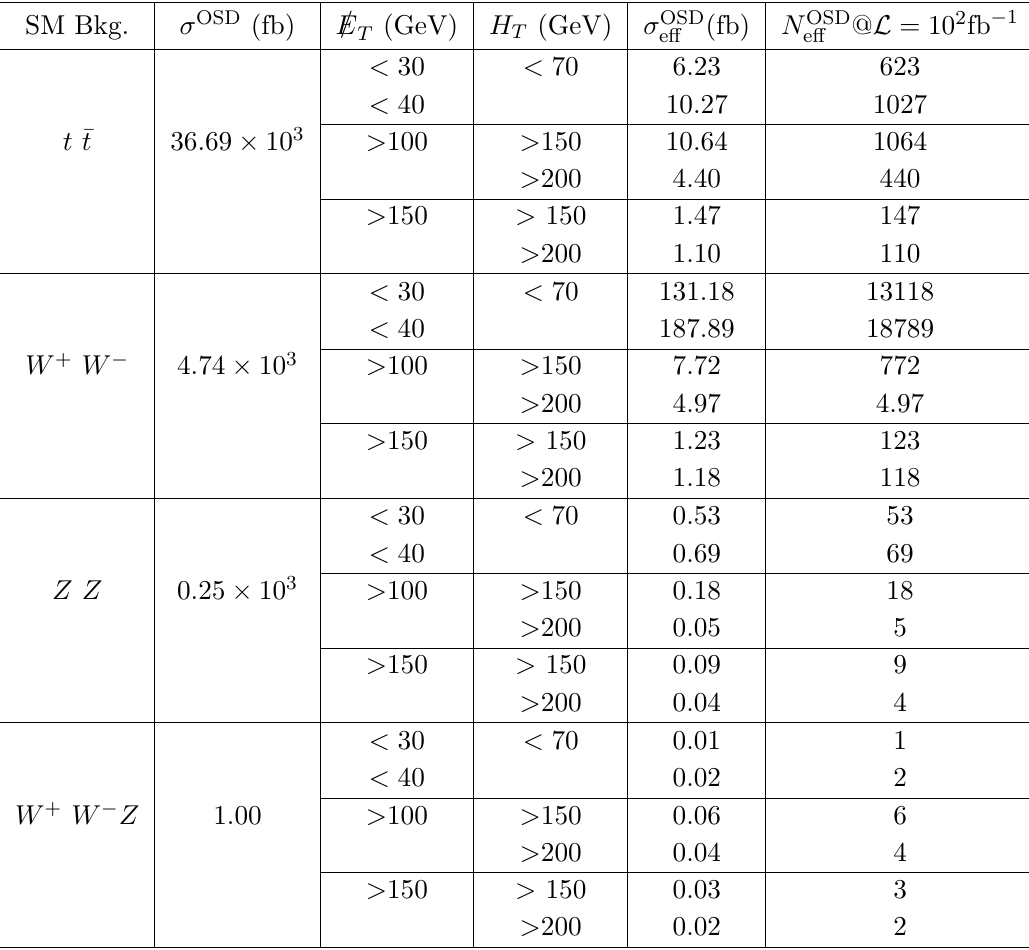
p ) signal events for s = 14 TeV at T , H T and m ‘‘ cuts T